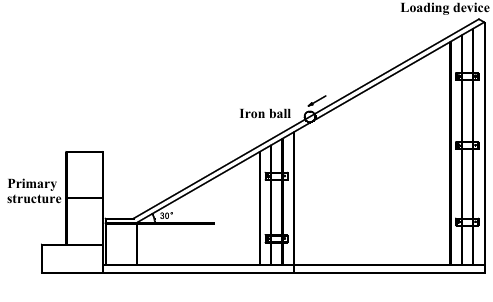
Figure 3. Experimental device.